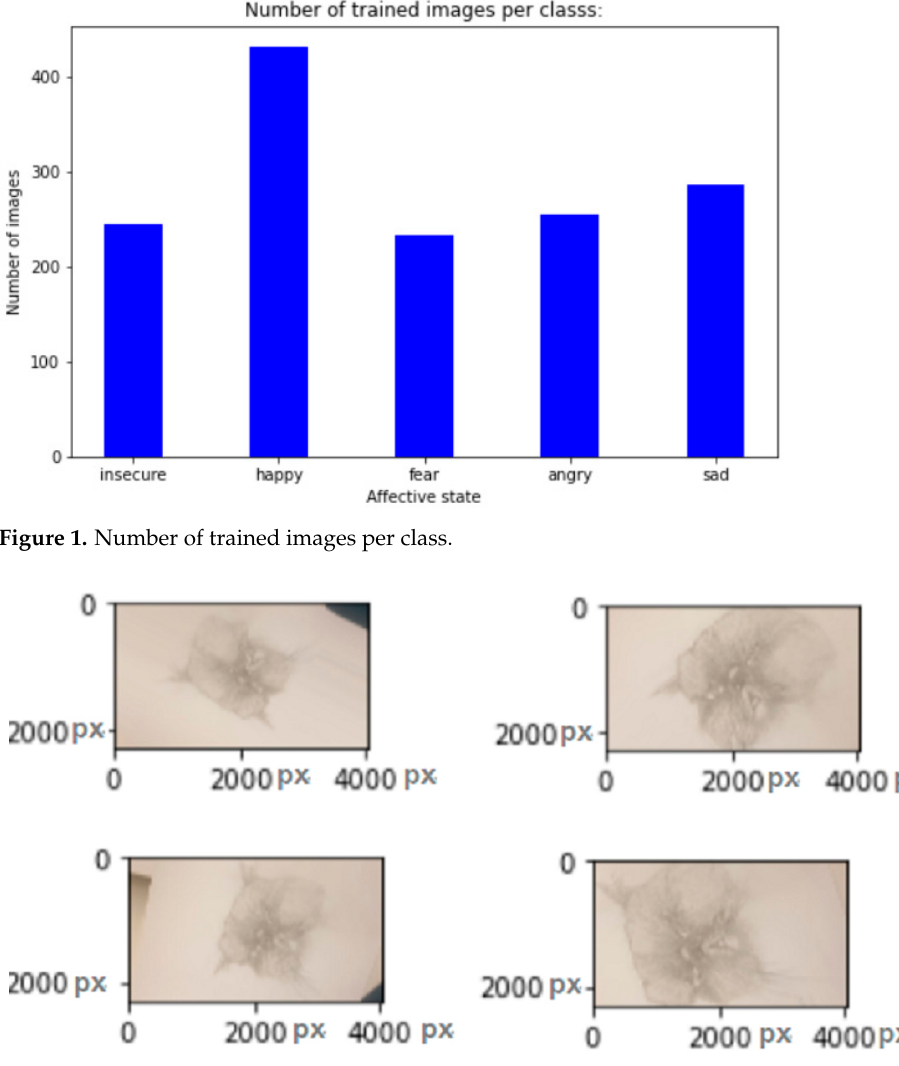
Figure 2. Image data augmentation.